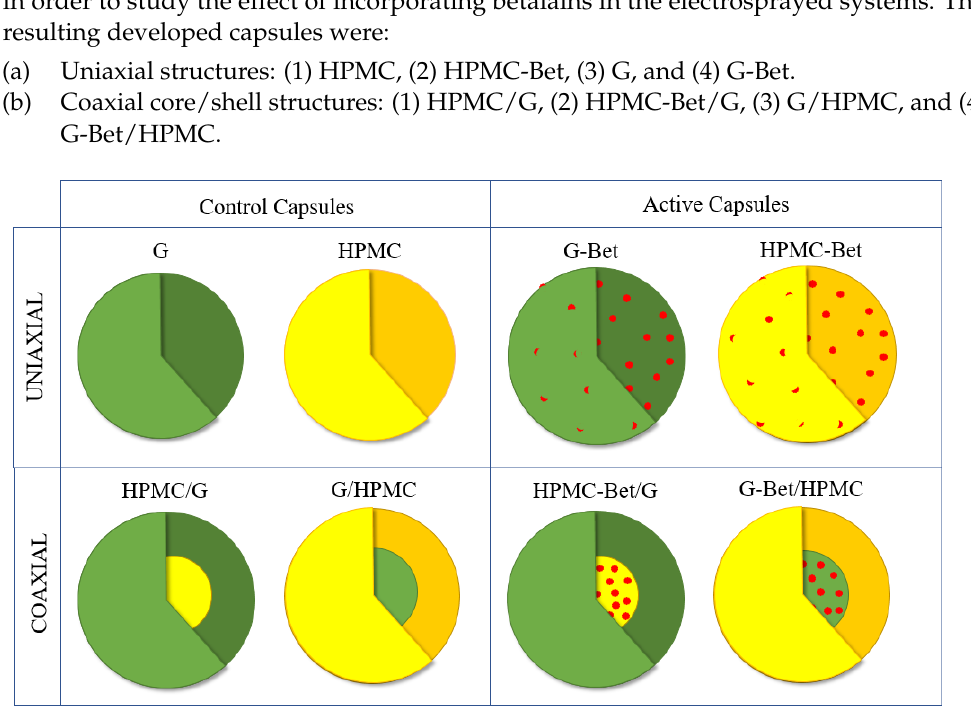
Figure 1. Scheme of developed electrosprayed capsules. In green: Gelatin (G); yellow: hydroxypropyl methylcellulose (HPMC); and red: beetroot extract (Bet). A lighter and darker color tone (green or yellow) was used to better represent the outer surface and inner bulk of the capsules, respectively. (Note: the colors of each component are for illustrative purposes only).